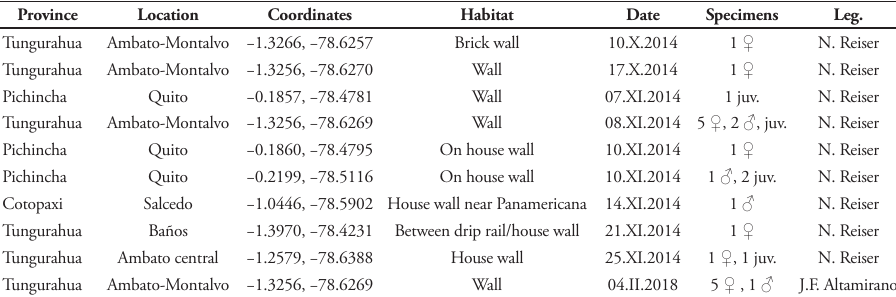
Table 2. Records of Steatoda nobilis in Ecuador.